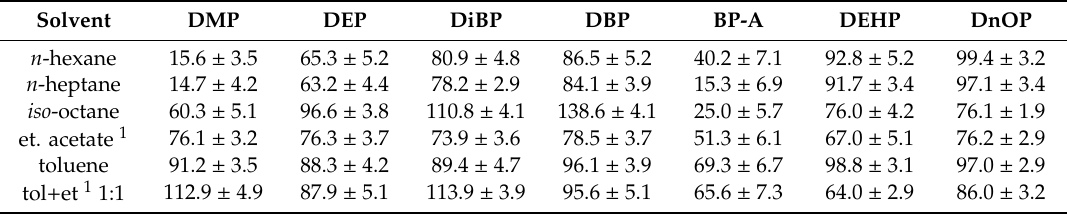
Table 2. Recoveries (% ± standard deviation) related to the effect of different solvents on nectar honey samples spiked with a mixed PAE/BP-A standard solution. The conditions were as follows: each PAE/BP-A at 50 ng mL −1 and 150 μL of extraction solvent.